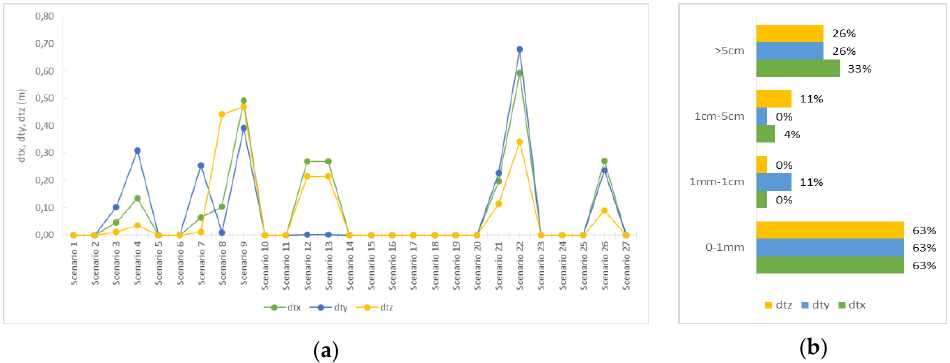
Figure 3. ( a ) Deviations in meters for translation per axis in the Euler angle method. ( b ) Histogram of deviations for translation per axis in the Euler angle method.